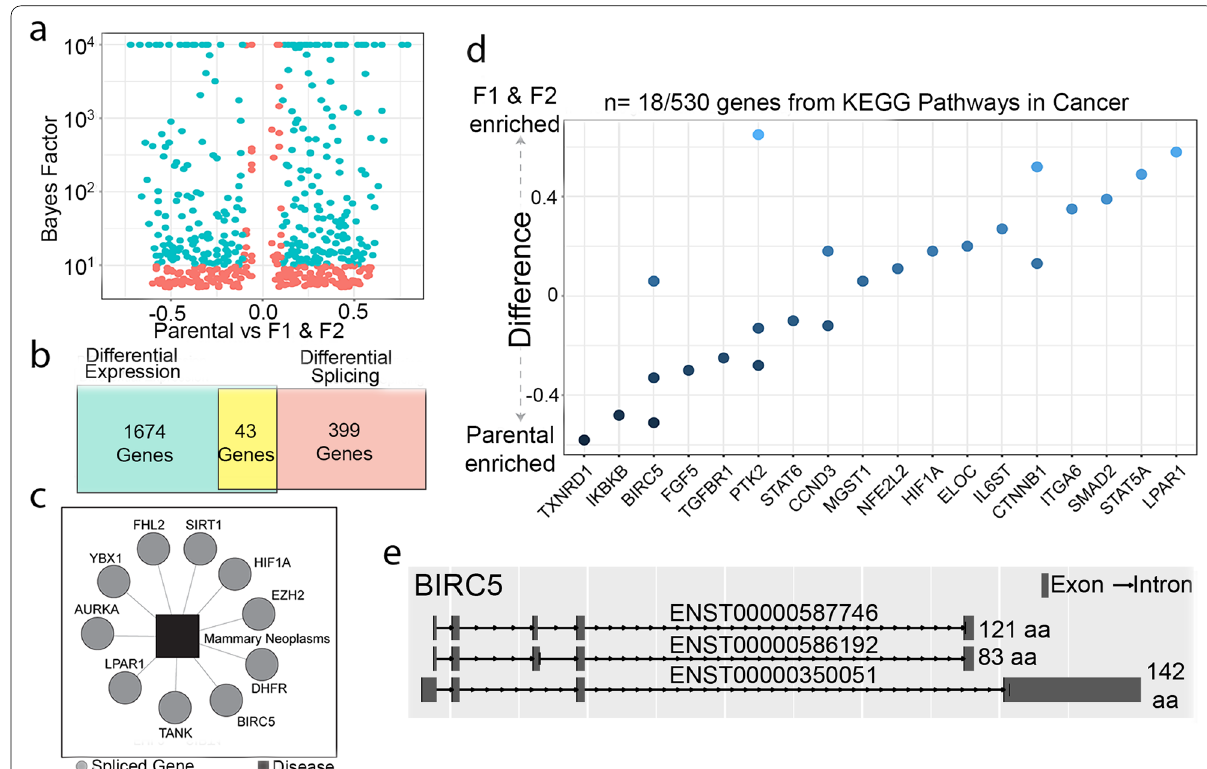
Fig. 3 Differential RNA-splicing and protein-protein interactions associated with cancer and metastasis were enriched in the F1 and F2 populations compared to parental population. a A volcano plot of the 526 differentially spliced transcripts. b Overall, 43 genes were both significantly differentially expressed and differentially spliced. c Gene-disease association analysis using DisGeNET revealed differentially spliced genes associated with mammary neoplasms. d KEGG pathway analysis identified differentially spliced genes included within the Pathways in Cancer geneset. e BIRC5 was one of the few genes that was both differentially expressed and differentially spliced. The three spliced variants of BIRC5 differentially spliced in the F1 and F2 populations are shown